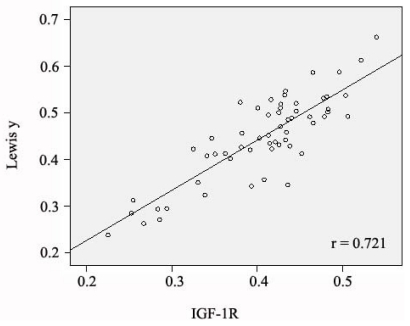
The scatterplot of MOD value of Lewis(y) and IGF-1R in ovarian cancer.